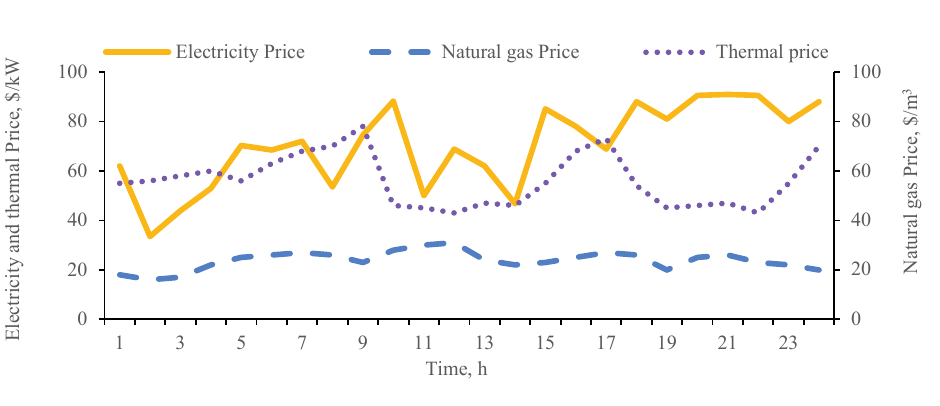
Fig. 4. Energy price in energy market.